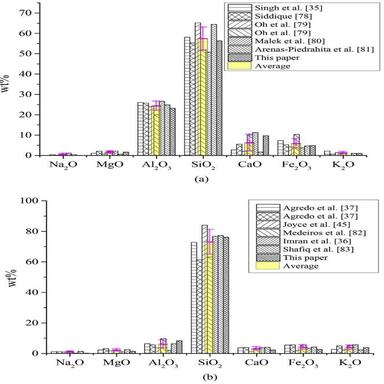
Compositional variations of SCBA and CFA (;;;;; fiq: (a) CFA (class F); and (b) SCBA.